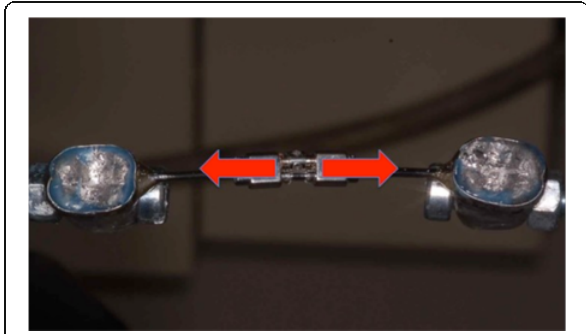
Fig. 10 Two-arm RPEs: no bending moment on the horizontal